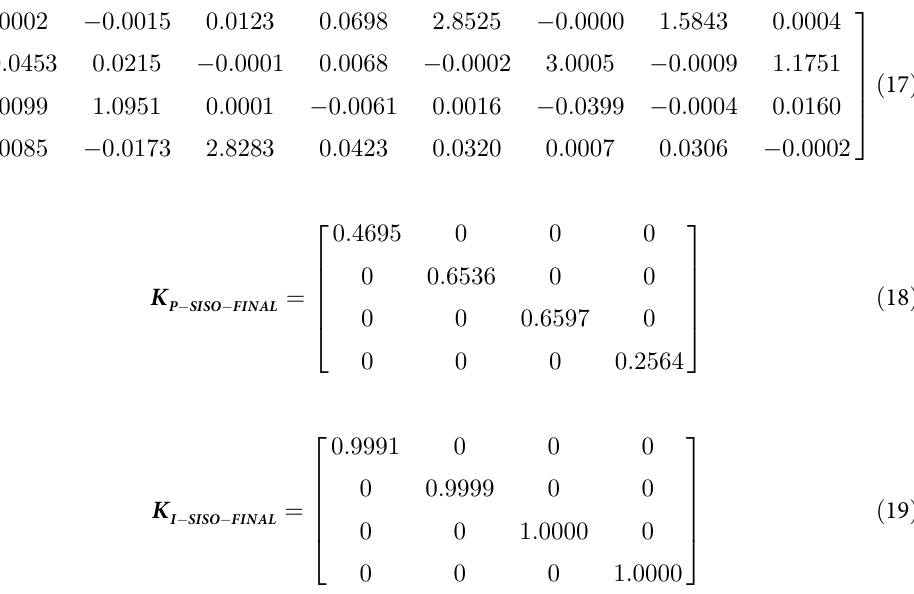
and K are given as fol- P−SISO I−SISO